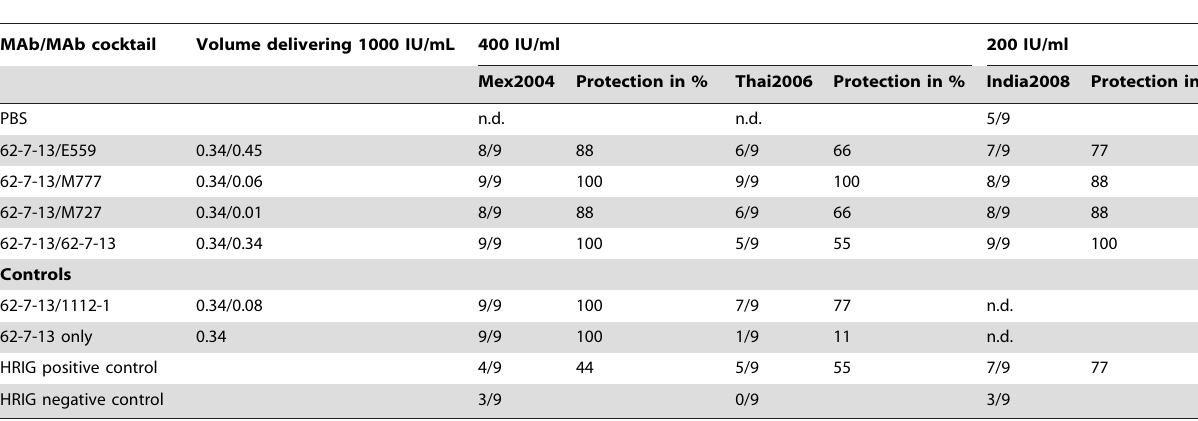
Table 5. Protection of hamsters challenged with RABV following treatment with MoMAb combination cocktails during three independent in vivo studies.